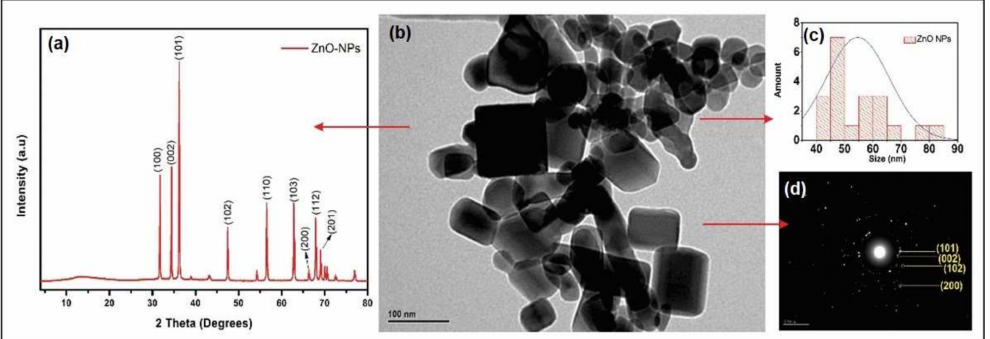
Figure 2. ( a ) XRD diffractogram of ZnO nanoparticles synthesized using DARC-AC1, ( b ) TEM micrography of obtained nanoparticles, ( c ) frequency histogram, and ( d ) SAED of